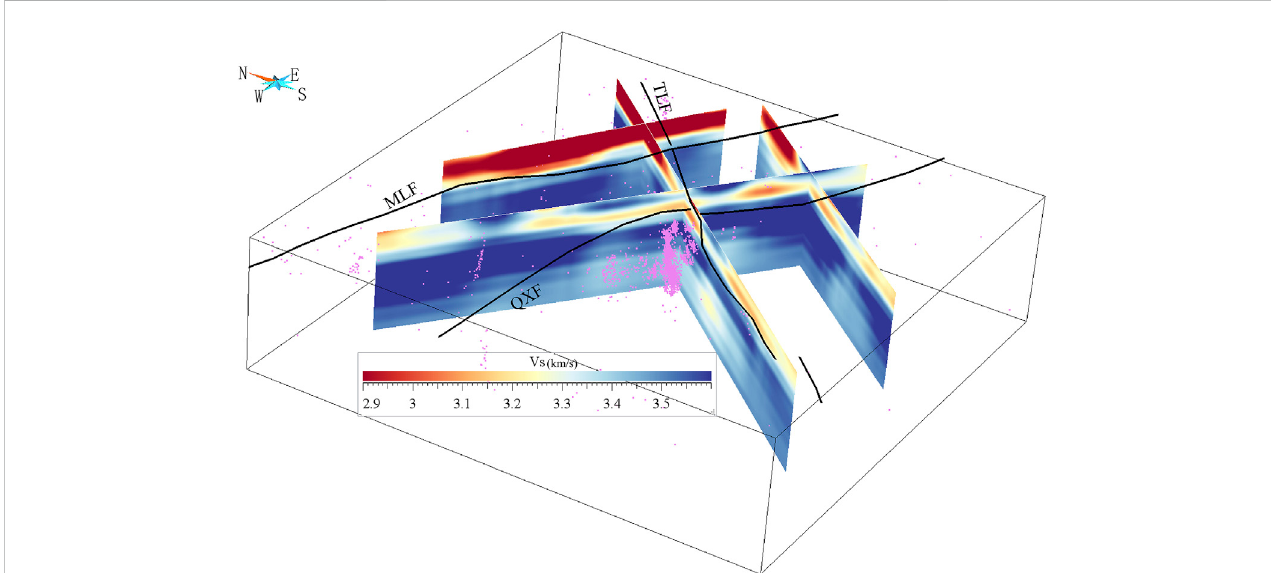
FIGURE 10 3-Dimensional map of the upper crust structure with the distribution of small earthquakes in Huoshan “ seismic window ” (Black lines on the surface are the known faults, and pink dots are the earthquake